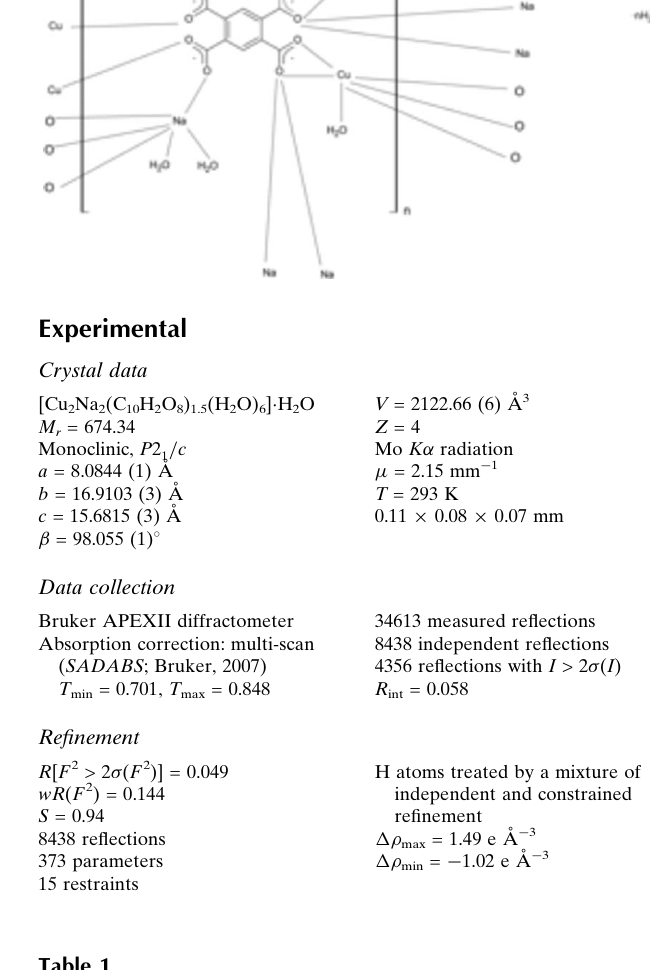
Hydrogen-bond geometry (A˚ , (cid:4)